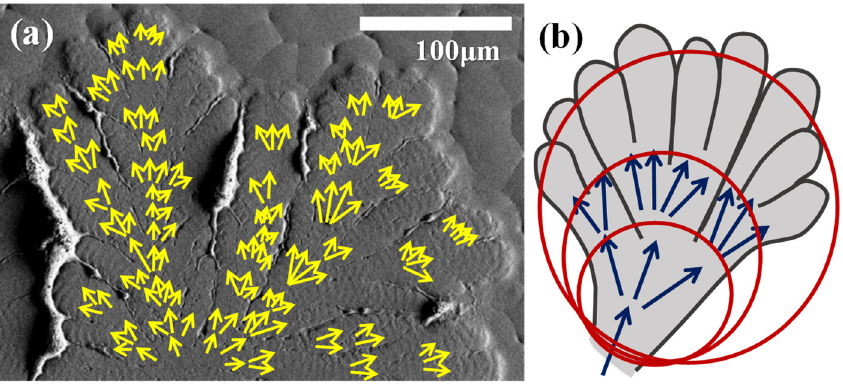
Figure 10. Dendritic-banded PPDO spherulite of PPDO/PVPh (75/25) blend crystallized at T c = 78 °C, ( a ) SEM micrographs, and ( b ) schematic of fractal growth of dendrite-branching pattern (rings accompanying the intermittent fractals).